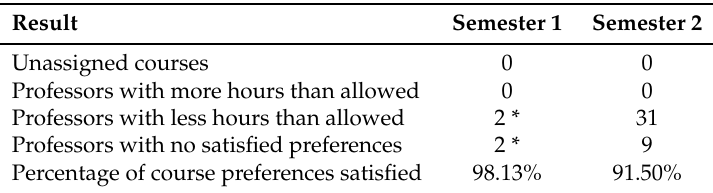
Table 2. Results obtained in the ACA stage for both semesters.